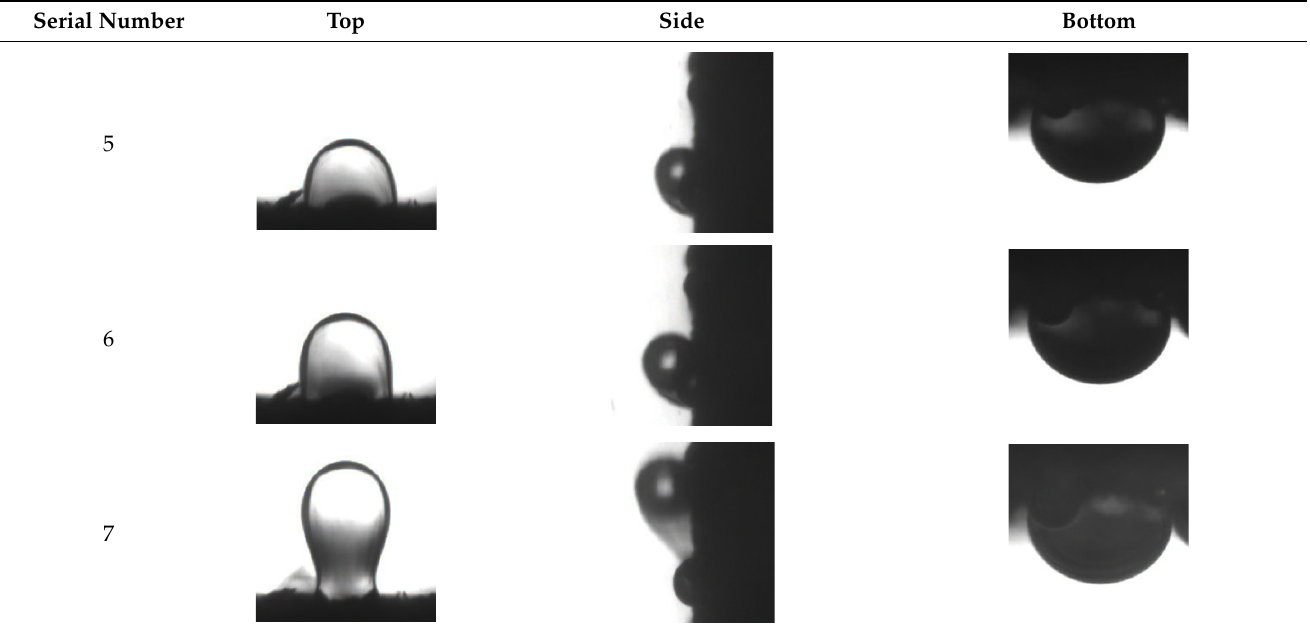
The growth rate and discharge characteristics of oil drops from the top, side, and bottom surfaces were very different. Compared with oil drop discharged from the bottom of the core, the oil drops discharged from the top and sides of the core grew faster and were easier to discharge. The pictures of oil drops at different positions at the same time interval are captured in Table 2. It could be clearly observed that the growth rate of oil drop from the top surface was the fastest, while the growth rate of oil drop from the bottom surface was the slowest. This was because when the core chip was immersed in the surfactant solution, the imbibition effectively occurred at 80 ◦ C. For the oil drops appearing on the wall of core, they were mainly affected by gravity, buoyancy, capillary force, and viscous force caused by the flow of external fluid. The difference between oil drops at the top and bottom of the core was mainly due to buoyancy [35]. When the oil drop was immersed in surfactant solution, it was mainly affected by the combined forces of vertical downward gravity, vertical upward buoyancy, and capillary force perpendicular to the wall surface. Capillary force was always a driving force for the growth and separation of oil drop. Therefore, for the oil drop emerging from the top surface of the core chip, the direction of the buoyancy force and capillary force was the same. In other words, in this case, buoyancy was an effective supplement to the growth of oil drop. Therefore, oil drop could be easily discharged from the surface of the core. On the contrary, for oil drop emerging from the bottom surface of the core chip, the buoyancy force was opposite to the capillary force, resulting in the buoyancy force acting as a resistance to the growth of the oil drop. Therefore, the growth rate of oil drop would become slower. For the oil drop emerging from the side of the core chip, the direction of buoyancy was perpendicular to the capillary force direction, so the buoyancy force was not as good at promoting the growth of the oil drop. For the oil drop discharged from the side of the core, compared with oil drops dis- charged from the top and bottom, the difference in oil drop size characteristics was too obvious to be able to be directly compared effectively. Therefore, the following mainly discussed the related characteristics of the growth of oil drops discharged from the top and bottom of the core chip. The change of oil drops during the experiment is shown in Figure